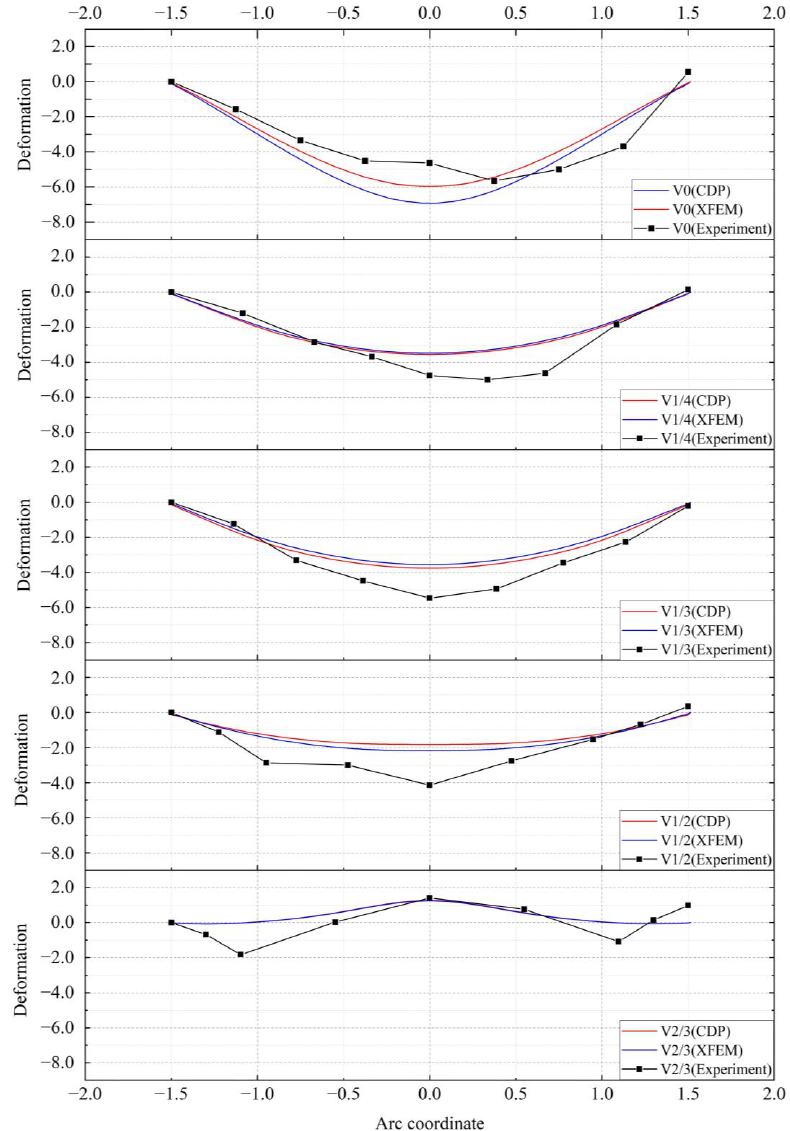
Figure 23. Bottom surface displacement.